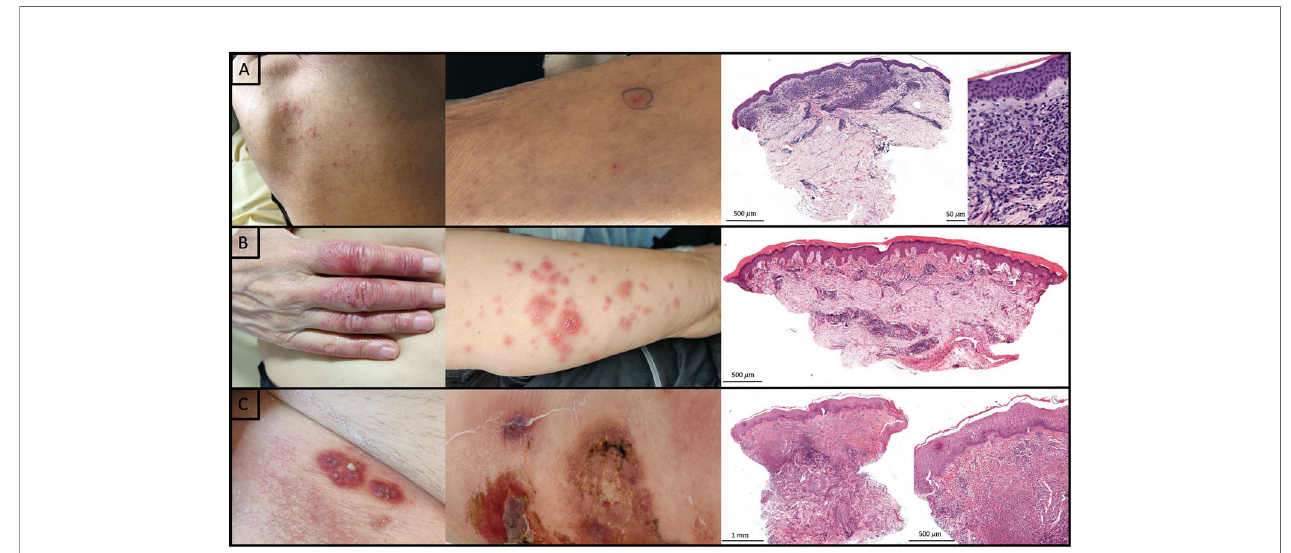
FIGURE 1 | Clinical and histological features of patient 6, 7, and 14. (A) Patient 6, from left to right: Erythematous excoriated papules of the back; Erythematous crusty papule of the arm in which was performed skin biopsy; Dense super fi cial dermal in fi ltrate of myeloid cells (CD68+ monocytes and rare MPO+ cells) associated with lymphocytes compatible with CMML cutis (Hematoxylin-eosin-saffron; Original magni fi cation respectively ×30 and ×400). (B) Patient 7, from left to right: papulonodular lesions of the hand and forearm; Dermal lymphohistiocytic in fi ltrate (Hematoxylin-eosin-saffron; Original magni fi cation ×25). (C) Patient 14, from left to right: violaceous pustular and ulcerated lesions; Dense dermal neutrophilic in fi ltrate with histiocytes (Hematoxylin-eosin-saffron; Original magni fi cation respectively ×25 and